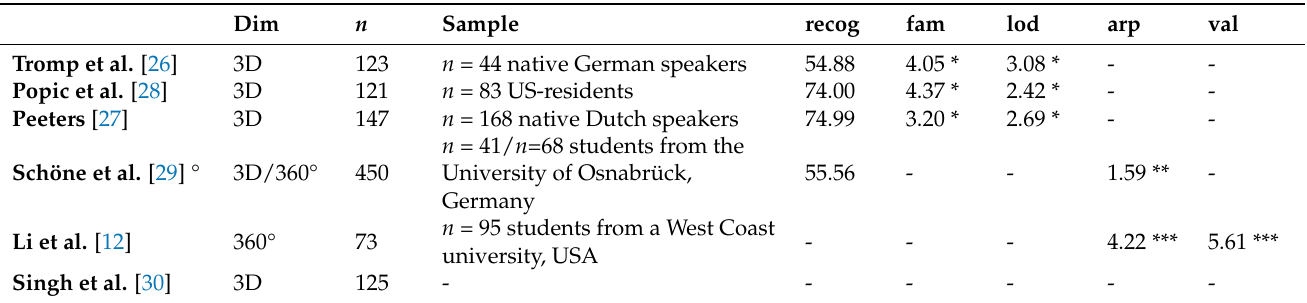
Table 1. 3D and 360° normative databases, their dimension, number of visual stimuli, and participants’ sample. N: number of visual stimuli; Dim: dimension; recog: recognition, recall, or name